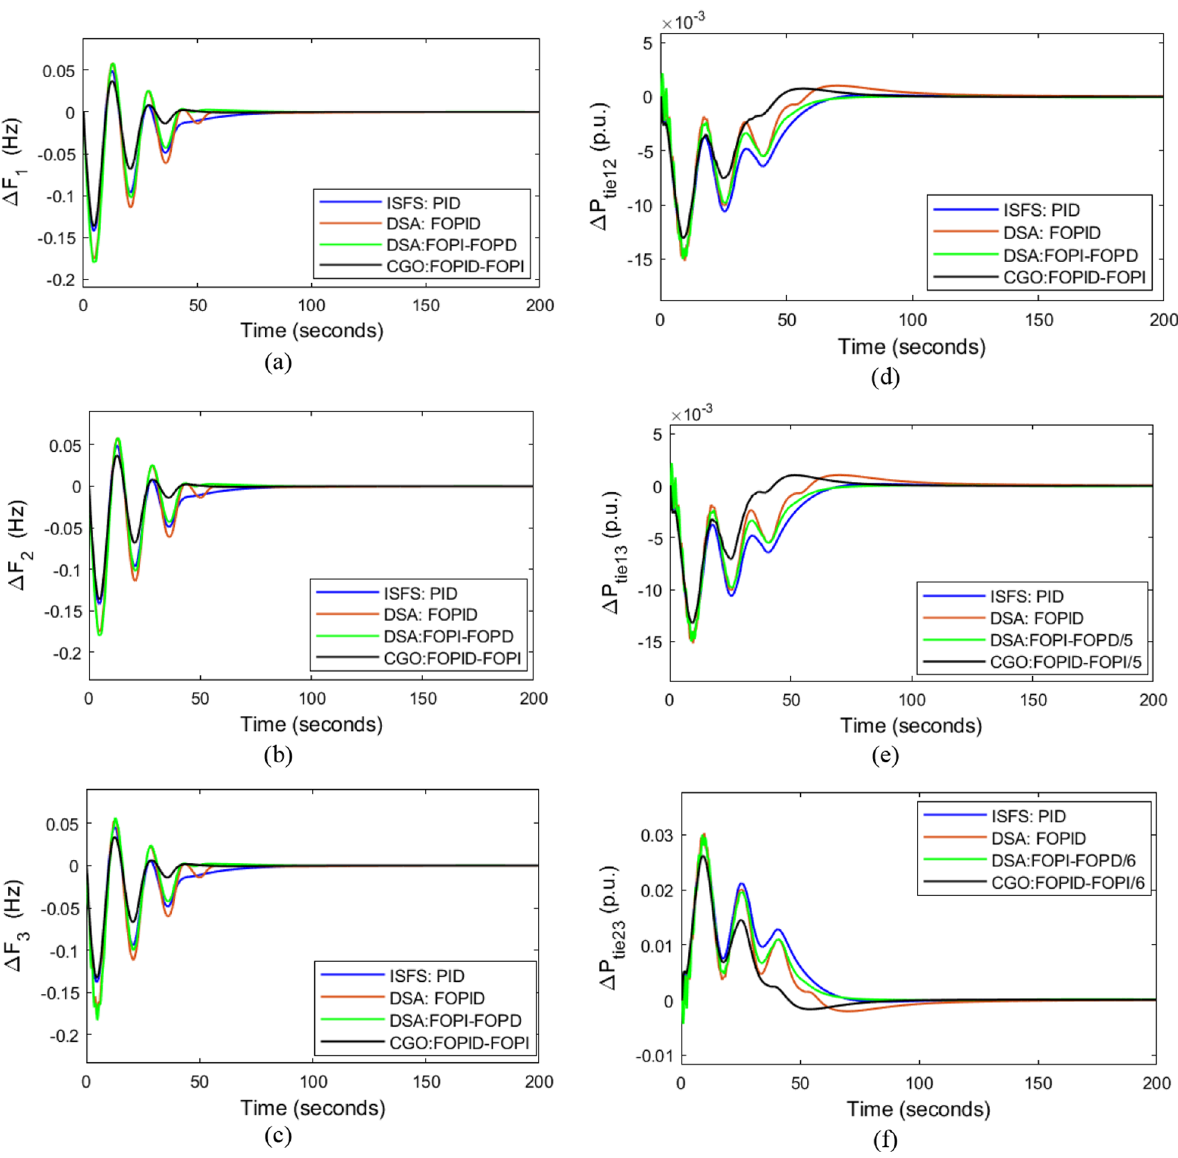
Fig. 14 Comparison of dynamic responses for Test-system 4 under 1% SLP applied in all areas: a ΔF 1 , b ΔF 2 , c ΔF 3 , d Δ P tie 1 , e Δ P tie 2 , and f Δ P tie